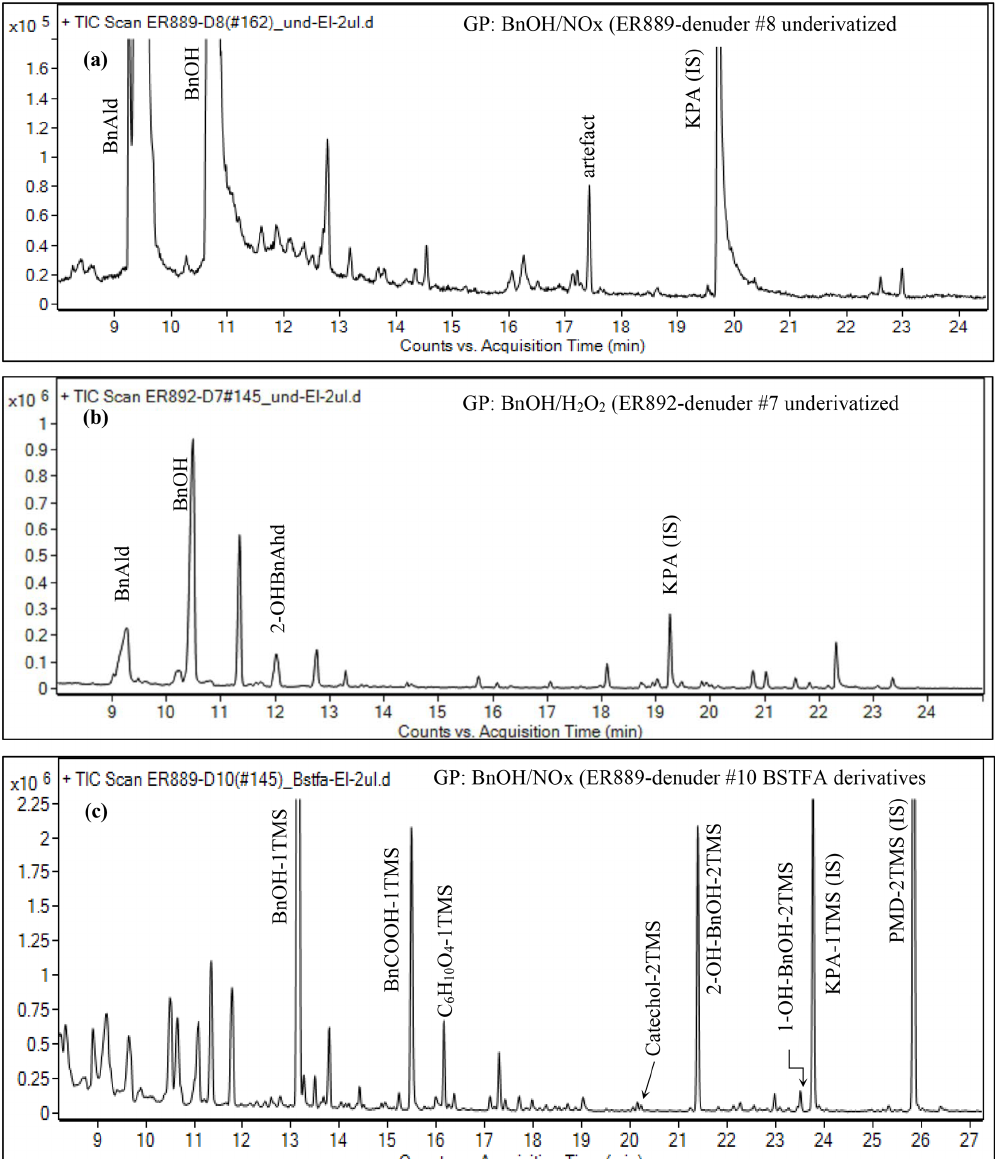
Figure 1. Portion of GC-MS total ion chromatogram in EI mode of GP underivatized denuder extract (a) ER889 (presence of NO x ), (b) ER892 (absence of NO x ), and (c) ER889 (presence of NO x ) as BSTFA